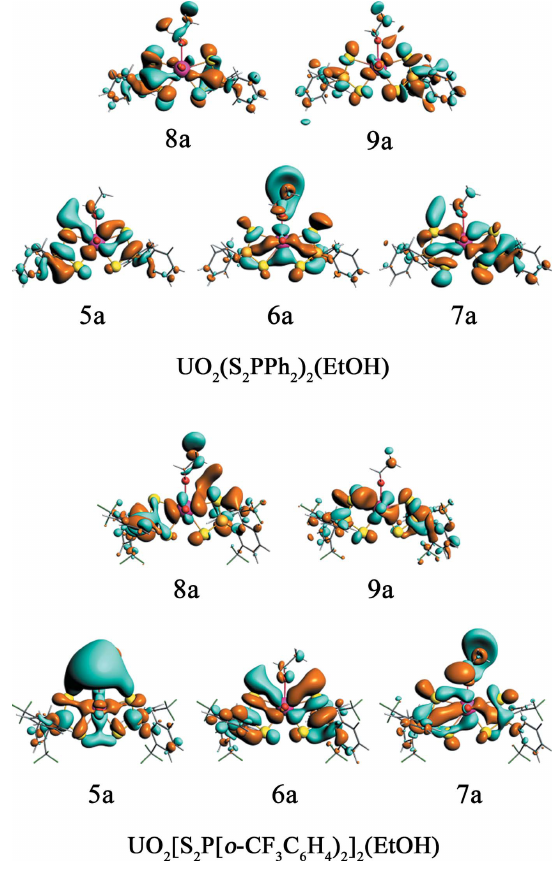
Figure 7 The contours of unoccupied Kohn–Sham orbitals (5–9a) containing primarily U 6 d character for UO 2 (S 2 P R 2 ) 2 (EtOH) in 0.02 a.u.